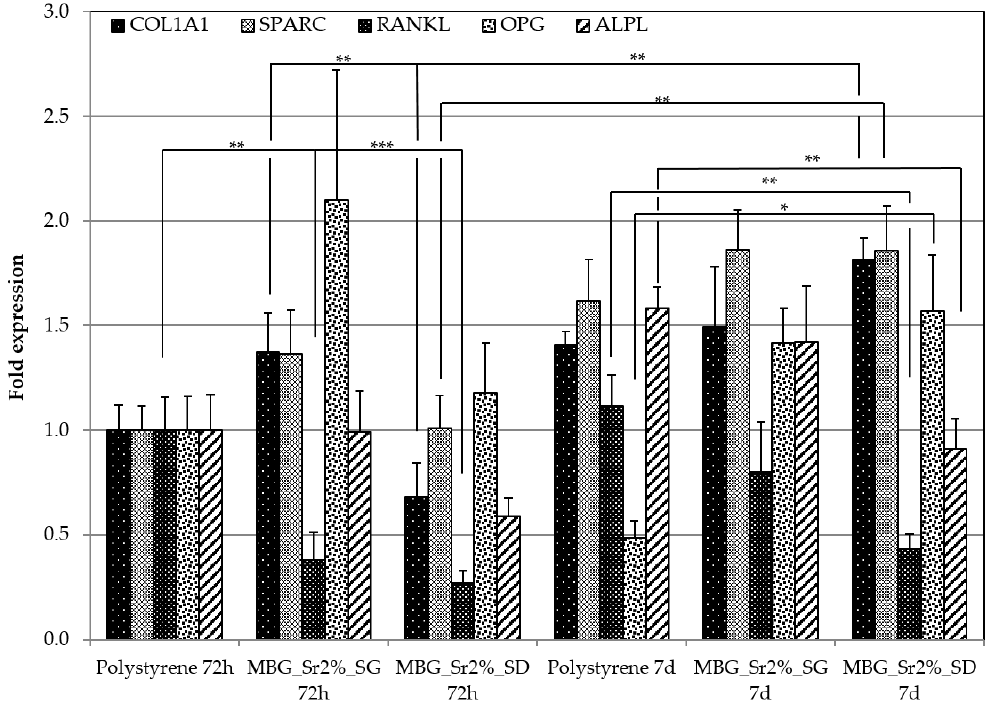
Figure 9. The expression level of the COL1A1, SPARC, RANKL, OPG and ALPL genes of osteoblast-like cells (SAOS2) analyzed by qRT-PCR at 72 h and at 7 days (* p ≤ 0.05, ** p ≤ 0.01 and *** p ≤ 0.001).